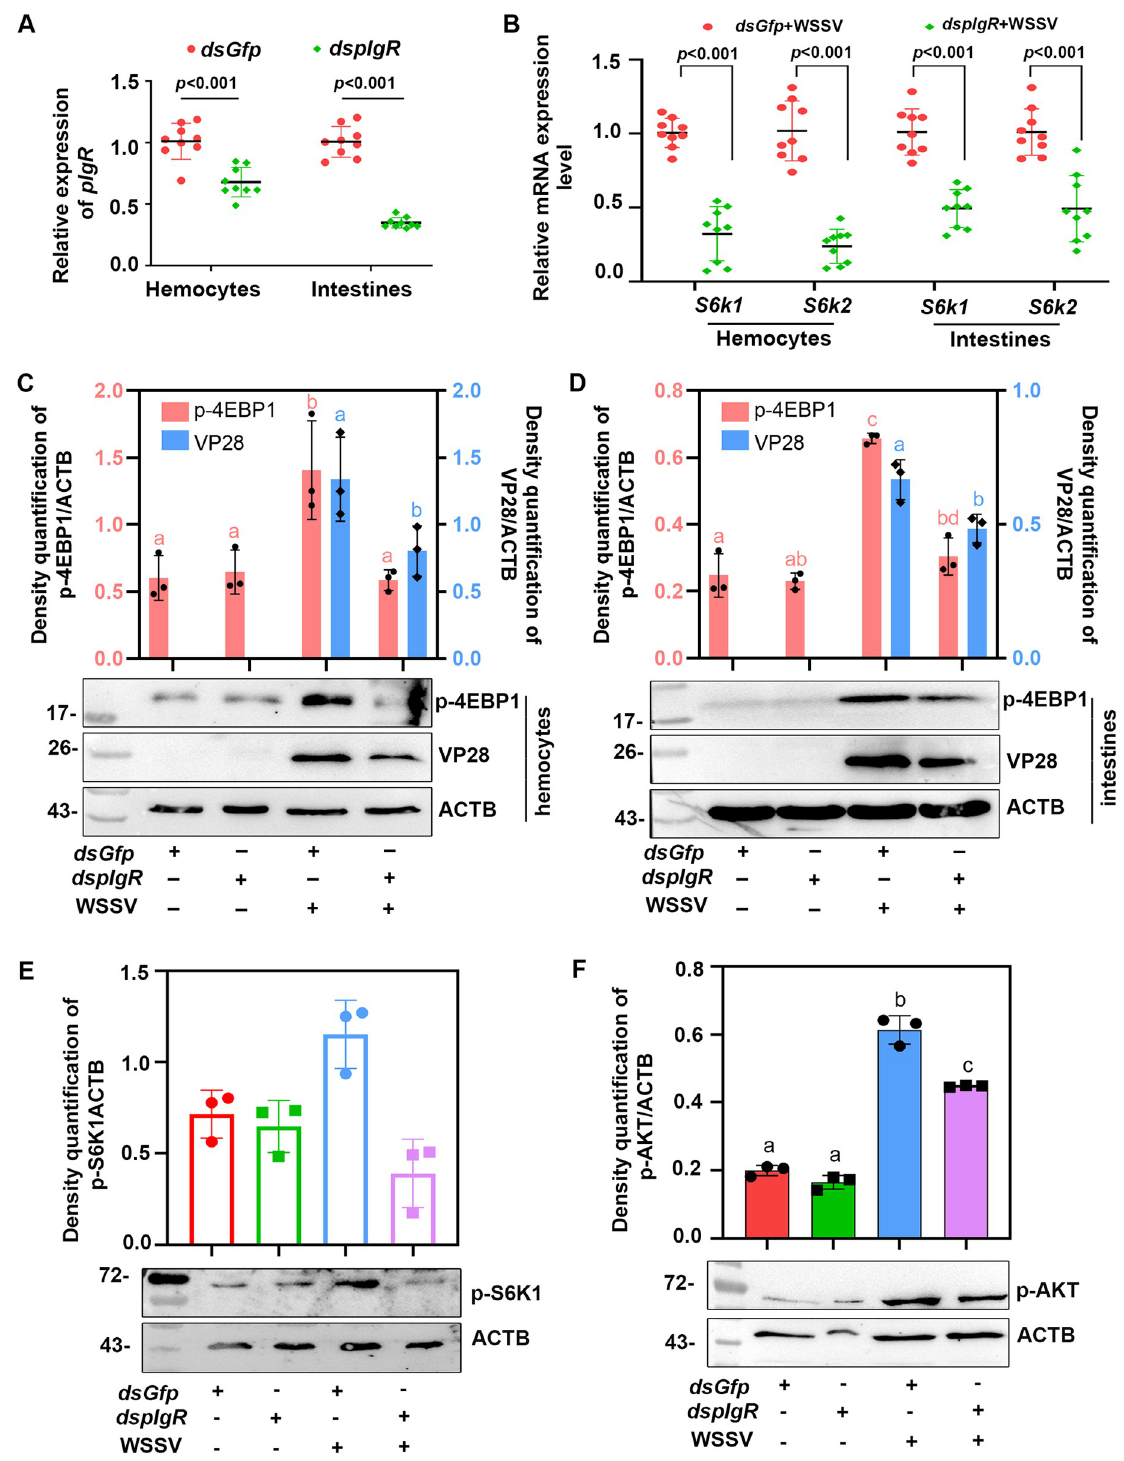
Fig 5. WSSV infection activates the mTORC1 signaling pathway through viral receptor, pIgR. ( A ) The efficiency of pIgR -RNAi in the hemocytes and intestines of shrimp analyzed by qPCR at 24 h post dsRNA injection. An injection with dsGfp was used as the control. ( B ) The level of mRNA expression of the downstream effectors of mTORC1, S6k1 and S6k2 , in the hemocytes of pIgR -knockdown shrimp, based on three independent experiments analyzed by qPCR at 36 hpi. ( C and D ) The level of VP28 expression and 4EBP1 phosphorylation in the hemocytes (C) and intestines (D) of pIgR -RNAi shrimp with or without WSSV infection as analyzed by Western blot at 36 hpi. The